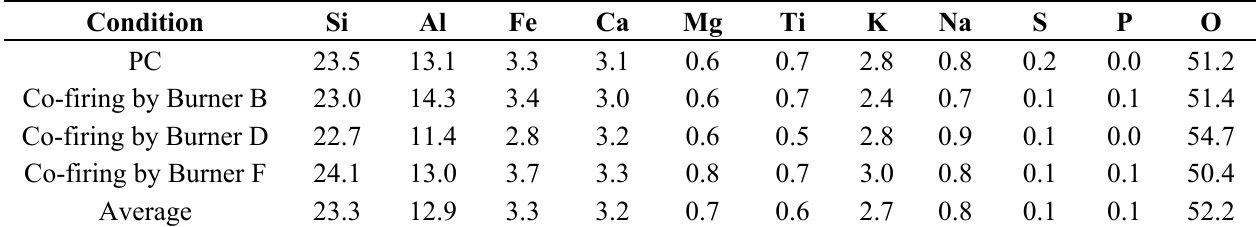
Table 4. XRF (X-ray fluorescence) analyzed results of fly ash.